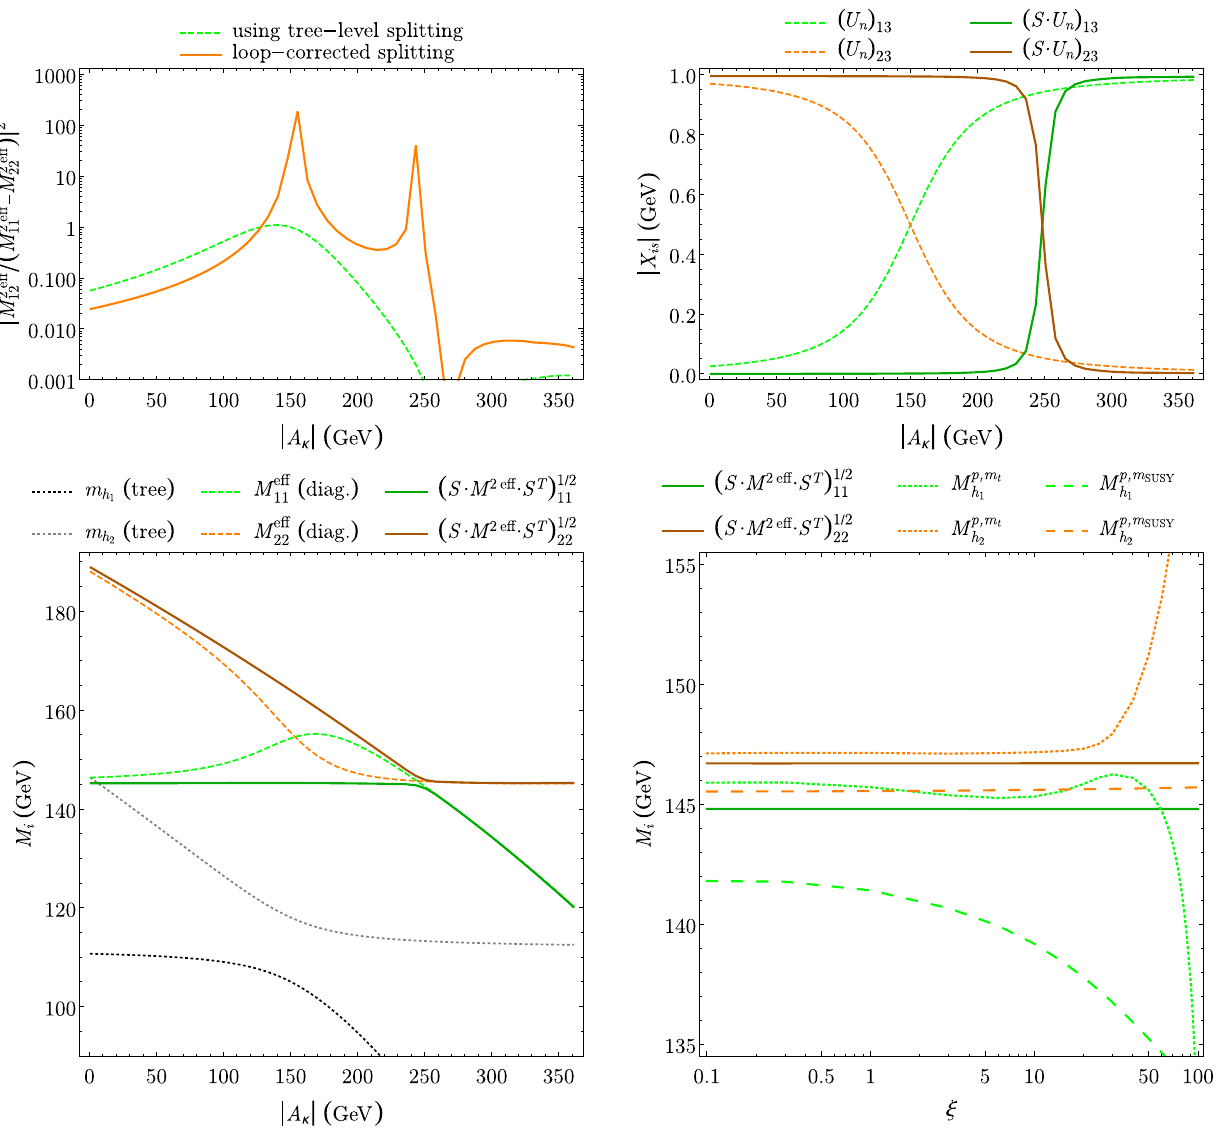
Fig. 11 The singlet–doublet mixing in the NMSSM is depicted for ing(dashed)orincludingit(solid)areshown.Thecorrespondingresults λ = 0 . 7, κ = 0 . 1, t β = 2, M = 1TeV, μ eff = 410GeV and varying are insensitive to the gauge-fixing parameter. The tree-level masses are H ± | A κ | . Upper left: The magnitude of the mixing-effect at radiative order represented as dotted lines. Lower right: The gauge-parameter depen- dence in the mass values at | A κ | (cid:16) 243GeV are depicted, obtained with respect to the tree-level (dashed green) and loop-corrected mass- splitting (solid orange) is shown. Upper right: The magnitude (squared) from the effective mass matrix (brown and dark-green solid horizontal of the singlet component in the Higgs fields before (dashed) and after lines), and from an iterative pole-search procedure (orange and green (solid) radiative mixing is displayed. Lower left: The mass values dottedordashedcurveswithfield-renormalizationscaleat m t or m SUSY obtained from the effective mass-matrix, neglecting the radiative mix-